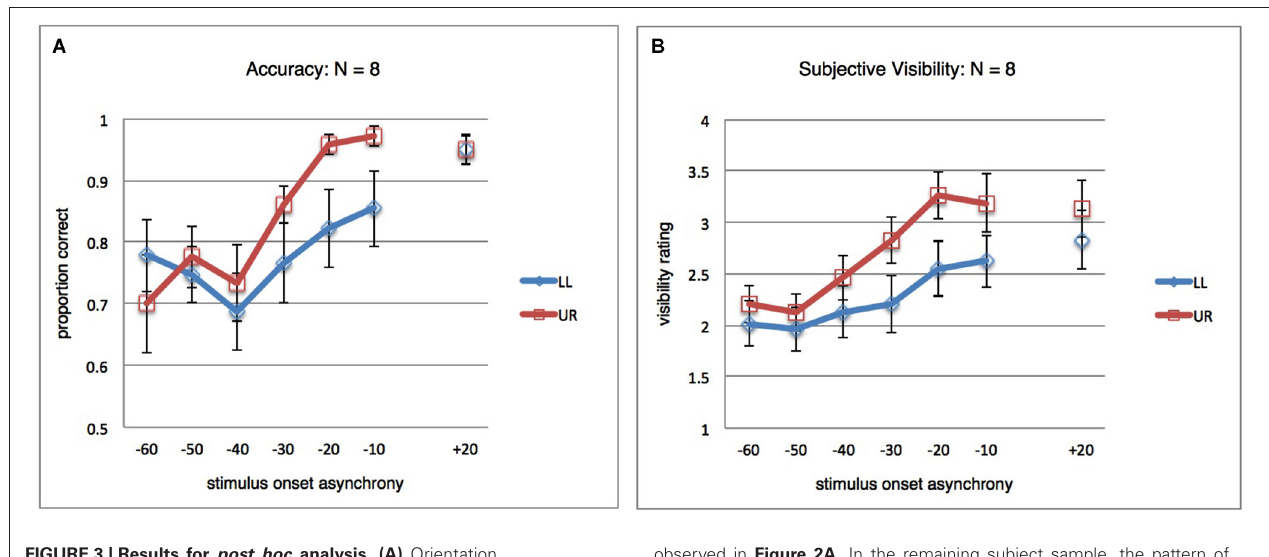
FIGURE 3 | Results for post hoc analysis. (A) Orientation discrimination accuracy, as in Figure 2A , but for a subset of participants ( N = 8). The four participants excluded here were responsible for the difference between LL and UR at SOA +20 ms